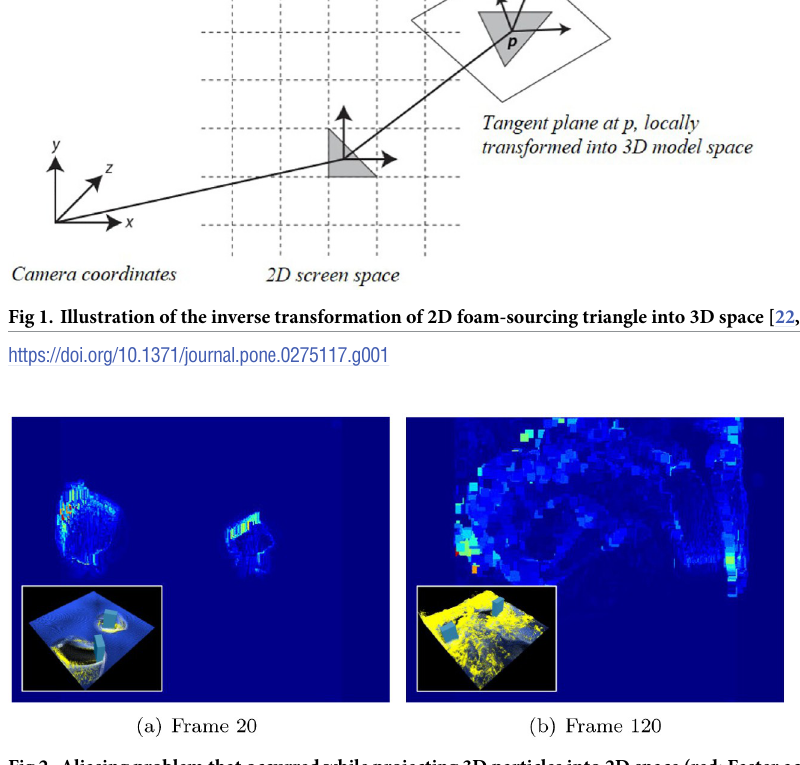
Fig 2. Aliasing problem that occurred while projecting 3D particles into 2D space (red: Faster acceleration). (a) Frame 20, (b) Frame